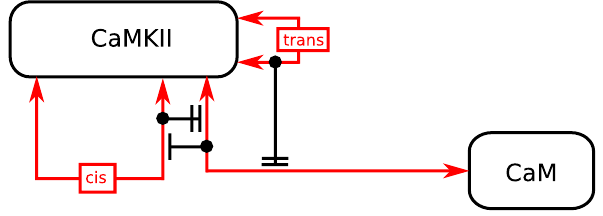
Figure 2.16: Examples of interactions , showing the effect of the binding of calmodulin to CaMKII (binary interaction) on the folding of the kinase (intra-molecular interaction), and the effect of the folding or the dimerisation of CaMKII (inter-molecular interaction between different instances of CaMKII) on the binding of